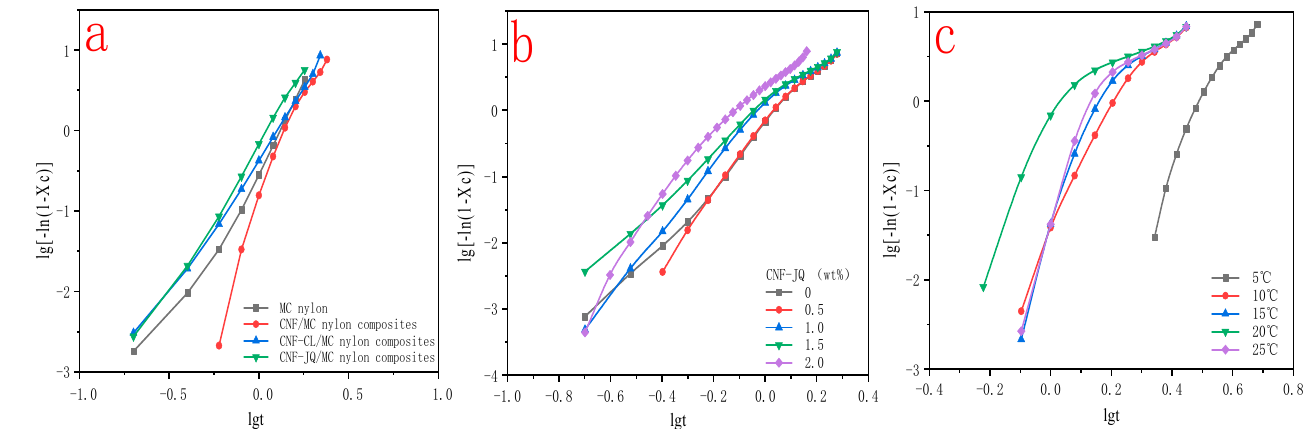
Figure 13. Curves of lgt versus lg[-ln(1-X(t))] for MC nylon and its composites (( a ) for different modified CNF at 10 ◦ C filler at 1.0 wt% cooling rate; ( b ) for different CNF − JQ additions at 15 ◦ C cooling rate; ( c ) for different cooling rates at 1.0 wt% CNF − JQ). Table 3. Crystallization kinetic parameters from Jeziorny’s model.